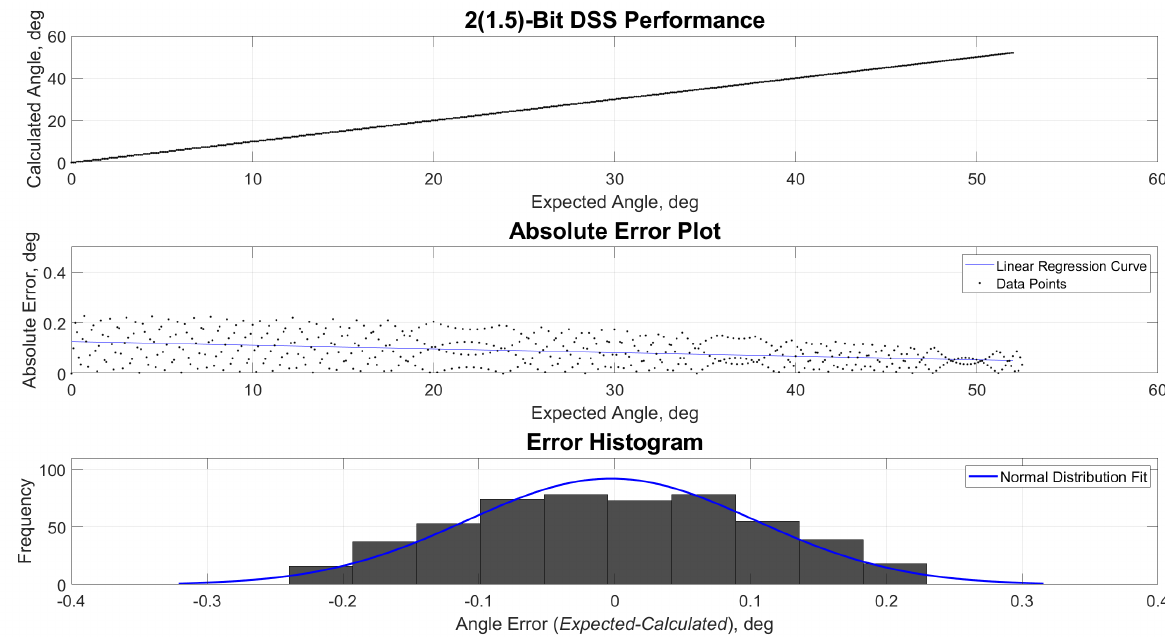
Figure 10. Performance, absolute error and error histogram plots for 2(1.5)-bit readout